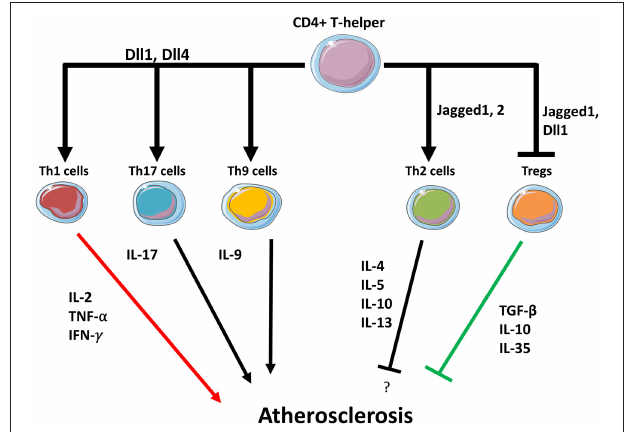
FIGURE 2 | Notch may regulate T helper cells fate in the plaque. Dll1 and Dll4 ligands expressed in APCs promote Th1, Th9, and Th17 differentiation while suppressing Th2 differentiation. Jagged1 induces Th2 differentiation. Dll1 and Jagged1 both suppress Tregs